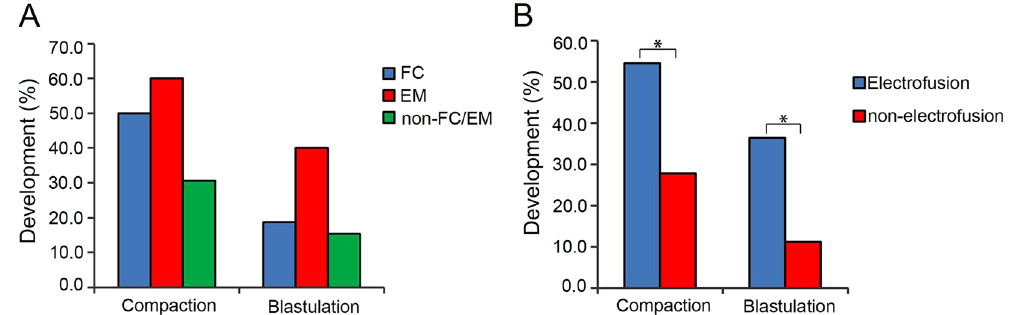
Figure 3. Diploidization could improve the developmental potential of HPs. ( A ) The percentage of compaction and blastulation of FC/EM and non-FC/EM HPs; ( B ) The percentage of compaction and blastulation of electrofusion and non-electrofusion HPs. HPs: haploid parthenotes, FC: failed cytokinesis, EM: endomitosis. An asterisk indicates a significant difference by a t-test (P <